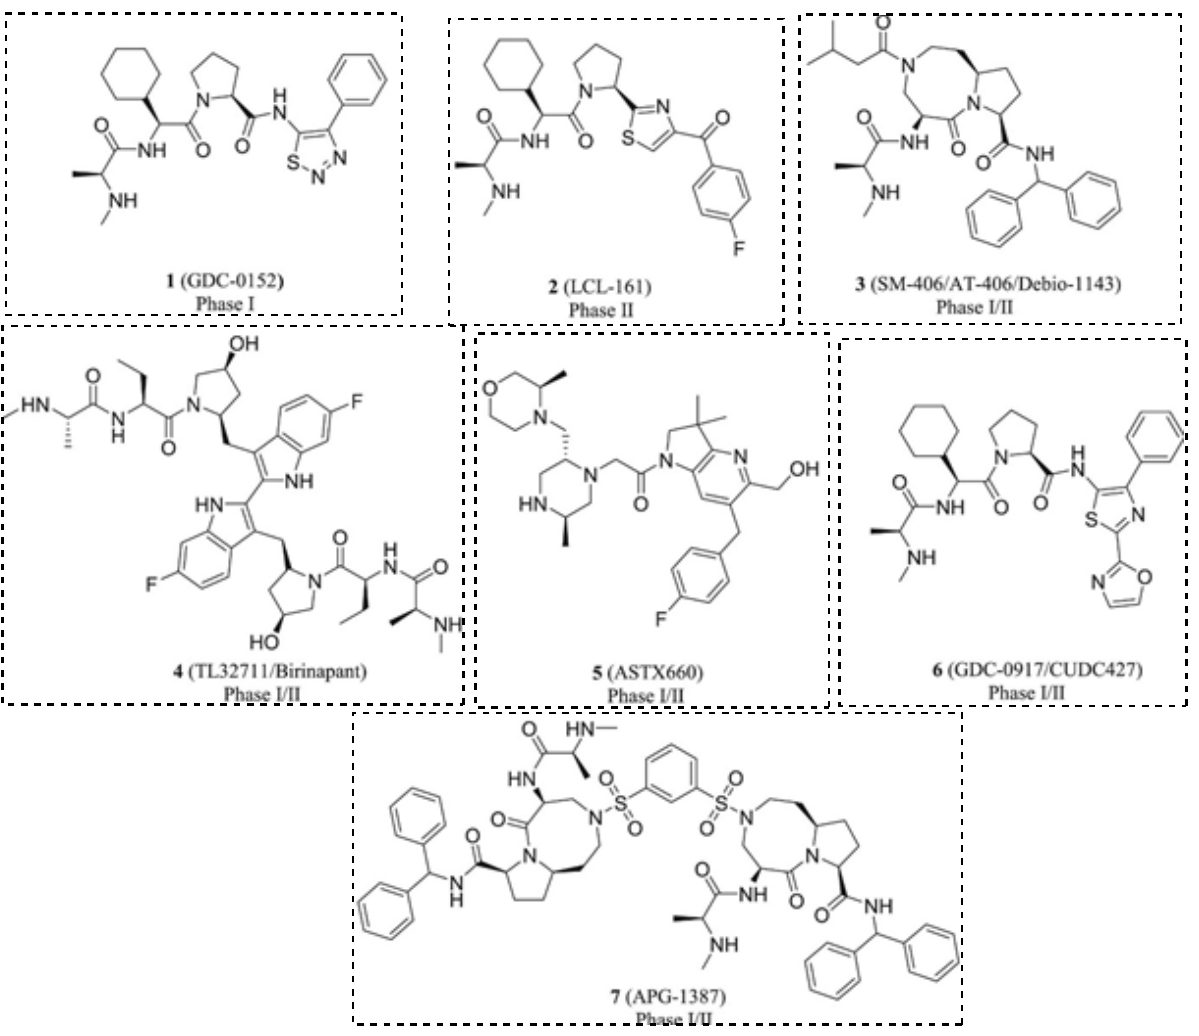
Figure 11. Reported IAP antagonists in clinical trials. Reproduced with permission from Lin et al. [50] Copyright 2021 Elsevier.